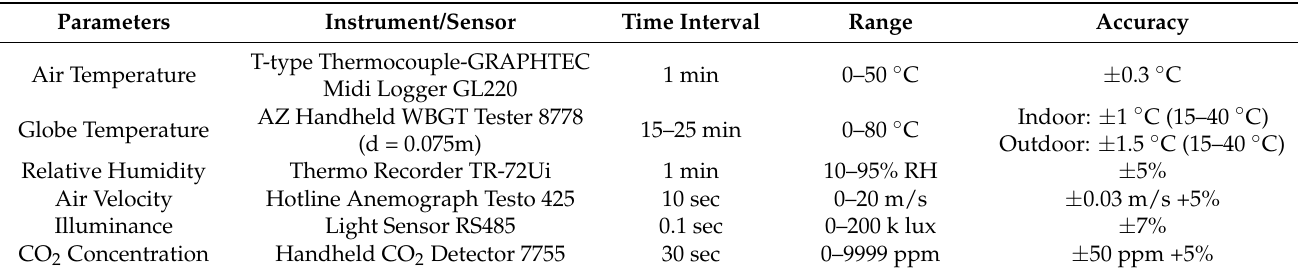
Table 3. Basic information of the experimental equipment.